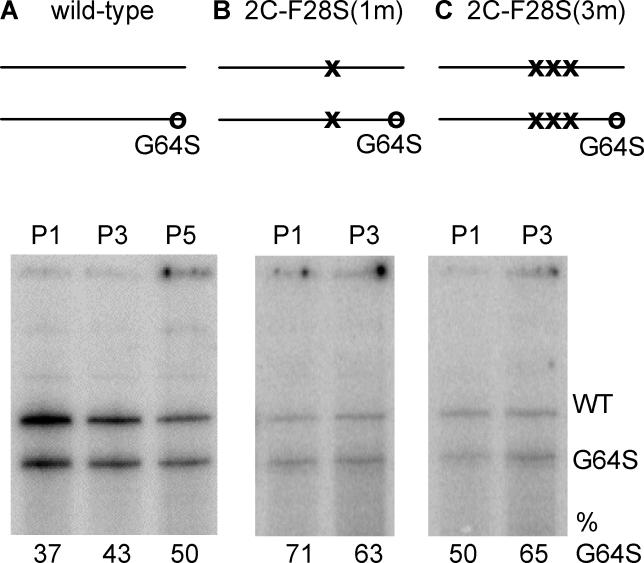
Serial Passage Competition Assay in HeLa Cells for Mixtures of Wild-Type and 3D-G64S Viruses Containing the 2C-F28S Temperature-Sensitive Attenuating MutationOne-to-one mixtures of 3D-G64S to WT virus containing the indicated 2C-F28S mutations were used to infect HeLa cells at an MOI of 0.1 PFU/cell at 32 °C. At 12 h post-infection, cell-associated RNA and virus were harvested, and the virus was titered to determine input for the next passage. This cycle was repeated three to five times, and representative gels of digestion products, with maps indicating the mutations at the 2C locus in the mixtures of viruses that were wild-type and 3D-G64S at the 3D locus, are shown: (A) wild-type, (B) 2C-F28S(1m), (C) 2C-F28S(3m). X denote the numbers of nucleotide substitutions at the 2C-F28S site, while O denotes the presence of the 3D-G64S mutation.DOI: 10.1371/journal.ppat.0010011.g005